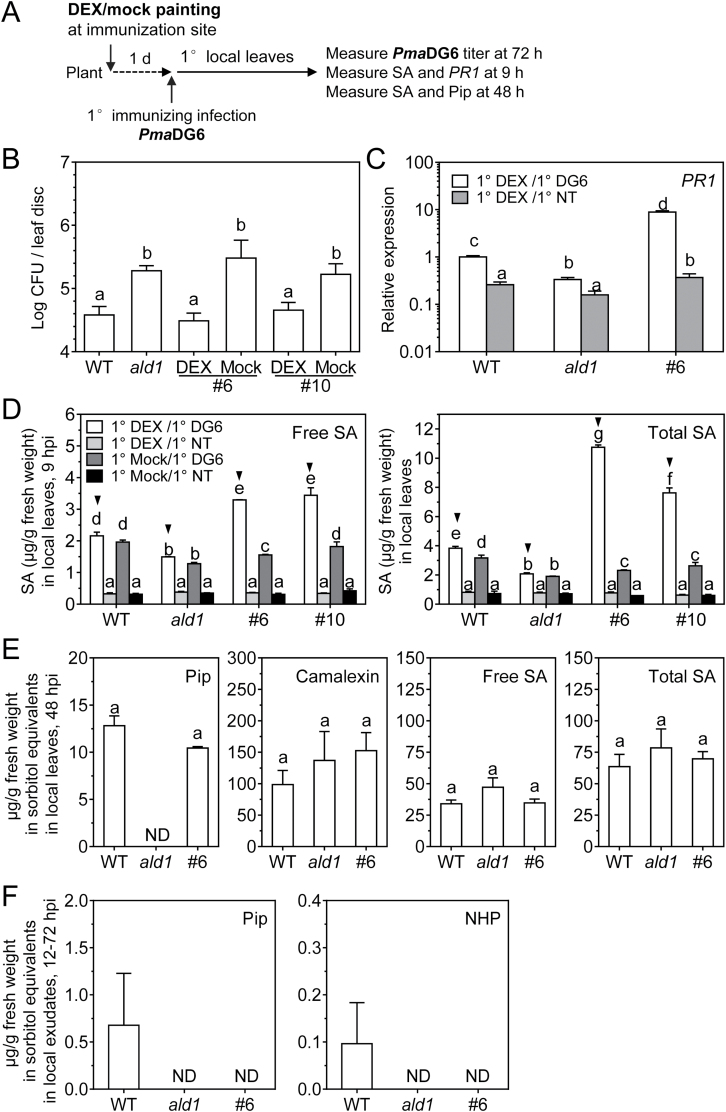
ALD1 accumulation at the site of infection fully restores defense responses in local leaves. (A) Treatment schemes in local leaves in (B–E). Local leaves (the third to fifth leaves) were painted with DEX (30 μM) or mock treated for 1 d, and then inoculated with PmaDG6. The primary (1°) local leaves were then collected at the indicated times for further analysis. (B) Titer of PmaDG6 in local leaves of the WT, ald1-T2 (ald1), and DEX- or mock-treated transgenic pDEX::ALD1 lines #6 and #10. Colony-forming unit (CFU) number was measured in local leaves on day 3 after infection with PmaDG6 (OD600=0.0001). Error bars indicate the SEM of eight biological replicates. The experiment was repeated three times with similar results. Another experiment that employed DEX spraying also showed similar results. (C) PR1 gene expression level in DEX- (30 μM) painted local leaves at 0 h (no treatment, NT) and 9 h after PmaDG6 (DG6, OD600=0.01) infection in the indicated genotypes: wild type (WT), ald1-T2 (ald1), and pDEX::ALD1#6 (#6). Error bars indicate the SEM from at least two biological replicates and three technical replicates. Each biological replicate consists of 6–9 leaves from at least three plants. The experiment was repeated twice with similar results. (D) Endogenous salicylic acid (SA) levels in local leaves were measured by HPLC in the indicated genotypes. DEX- (30 μM) or mock-painted local leaves were collected at 0 h (no treatment, NT) or 9 h after PmaDG6 (DG6, OD600=0.01) infection. Free SA is shown in the left panel, and total SA is shown in the right panel. Error bars indicate the SEM of at least three biological replicates. Each biological replicate consists of 6–9 leaves from at least three plants. (E) Defense-related metabolite levels measured by GC-MS in local leaves of the indicated genotypes after 48 h infection. Error bars indicate the SEM from four biological replicates. (F) Pip and NHP levels in petiole exudates are not rescued in pDEX::ALD1 plants. Plants at ~4 weeks old of the WT, ald1, and pDEX::ALD1#6 (#6) were sprayed with 30 μM DEX for 1 d before infection. Petiole exudates were collected during 12–72 h post-local inoculation of the SAR-inducing PmaDG6 strain (OD600=0.01). Metabolite levels measured by GC-MS. Results are the average with the SE from six biological replicates. Each biological replicate contains 12 leaves in 1.4 ml of 1 mM Na2-EDTA (pH 8.0) solution. Different letters indicate statistically significant differences (P<0.05, ANOVA, Fisher’s LSD test). ND, not detected; hpi, hours post-infection.